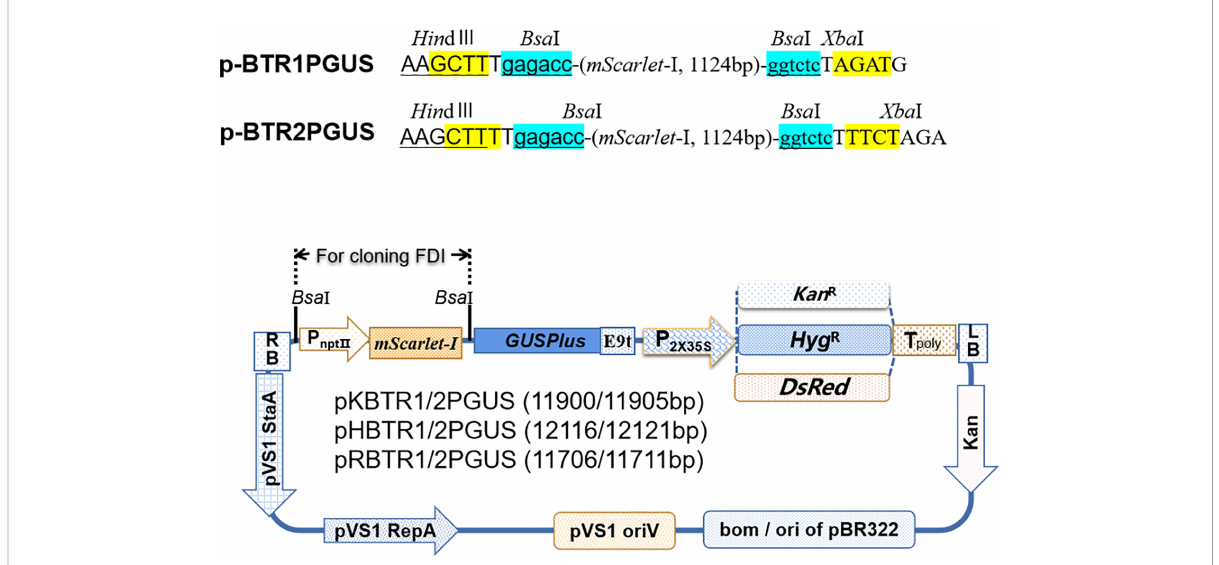
FIGURE 2 Diagrams of promoter analysis vectors. Hin dIII and Xba I restriction enzyme recognition sites for further screening of positive recombinants in E . coli are given. The vectors pKBTR1/2PGUS, pHBTR1/2PGUS, and pRBTR1/2PGUS carrying a Kan R , Hyg R , and DsRed gene, respectively, driven by CaMV 35S (enhancer were deleted) were used as selection markers in plant. Sticky ends produced after digestion by Bsa I are highlighted in yellow.